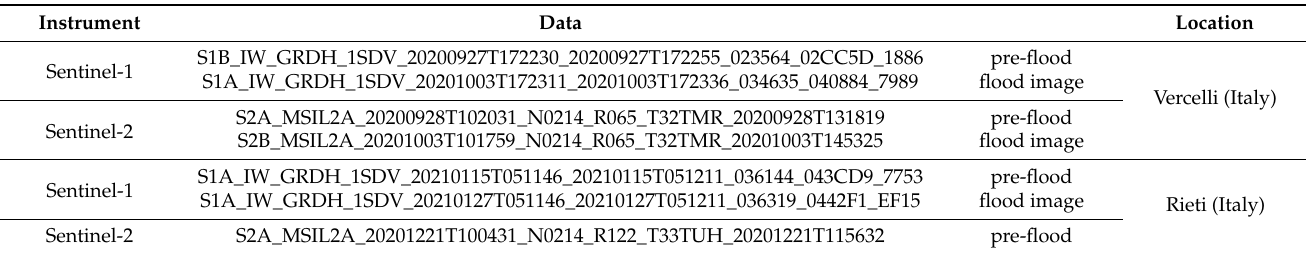
Table 4. S1-GRD slices and S2-L2A tiles used in this study for flooded vegetation mapping.